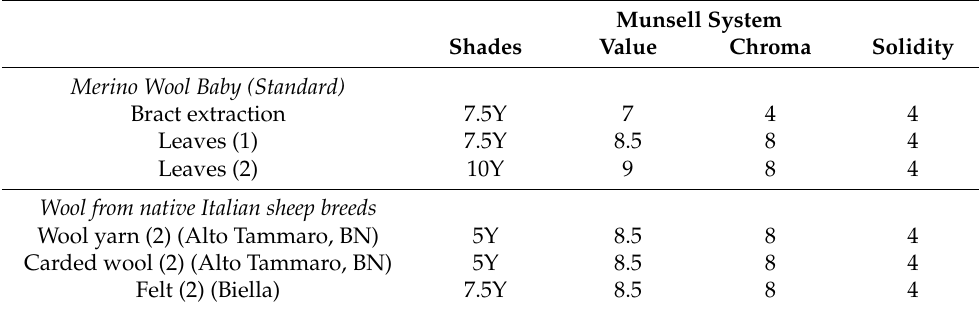
Table 9. Classification of dyed material according to the Munsell